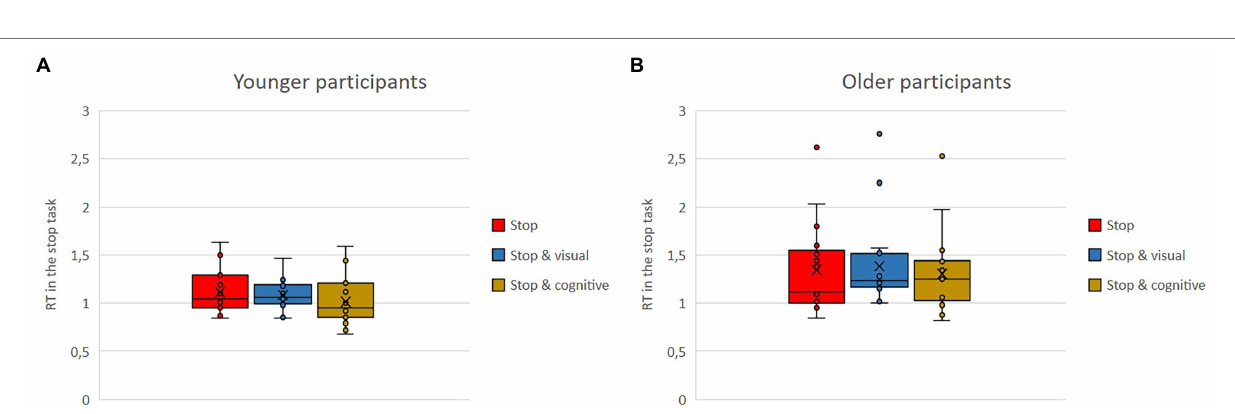
FIGURE 5 | (A,B) Means of errors in the go task, as single vs. dual-task conditions with either the visual or the cognitive secondary task for the older and younger